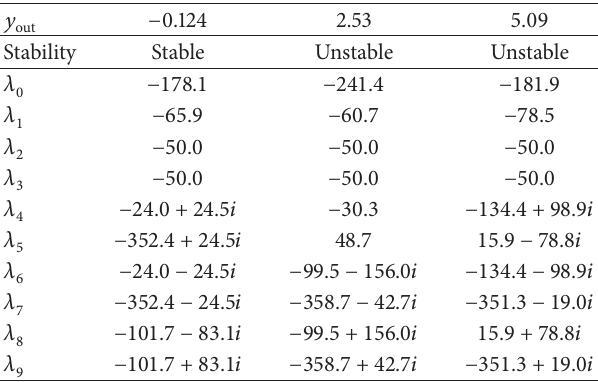
Table 3: Eigenvalues for Phase 1, 𝐵 = 45 .